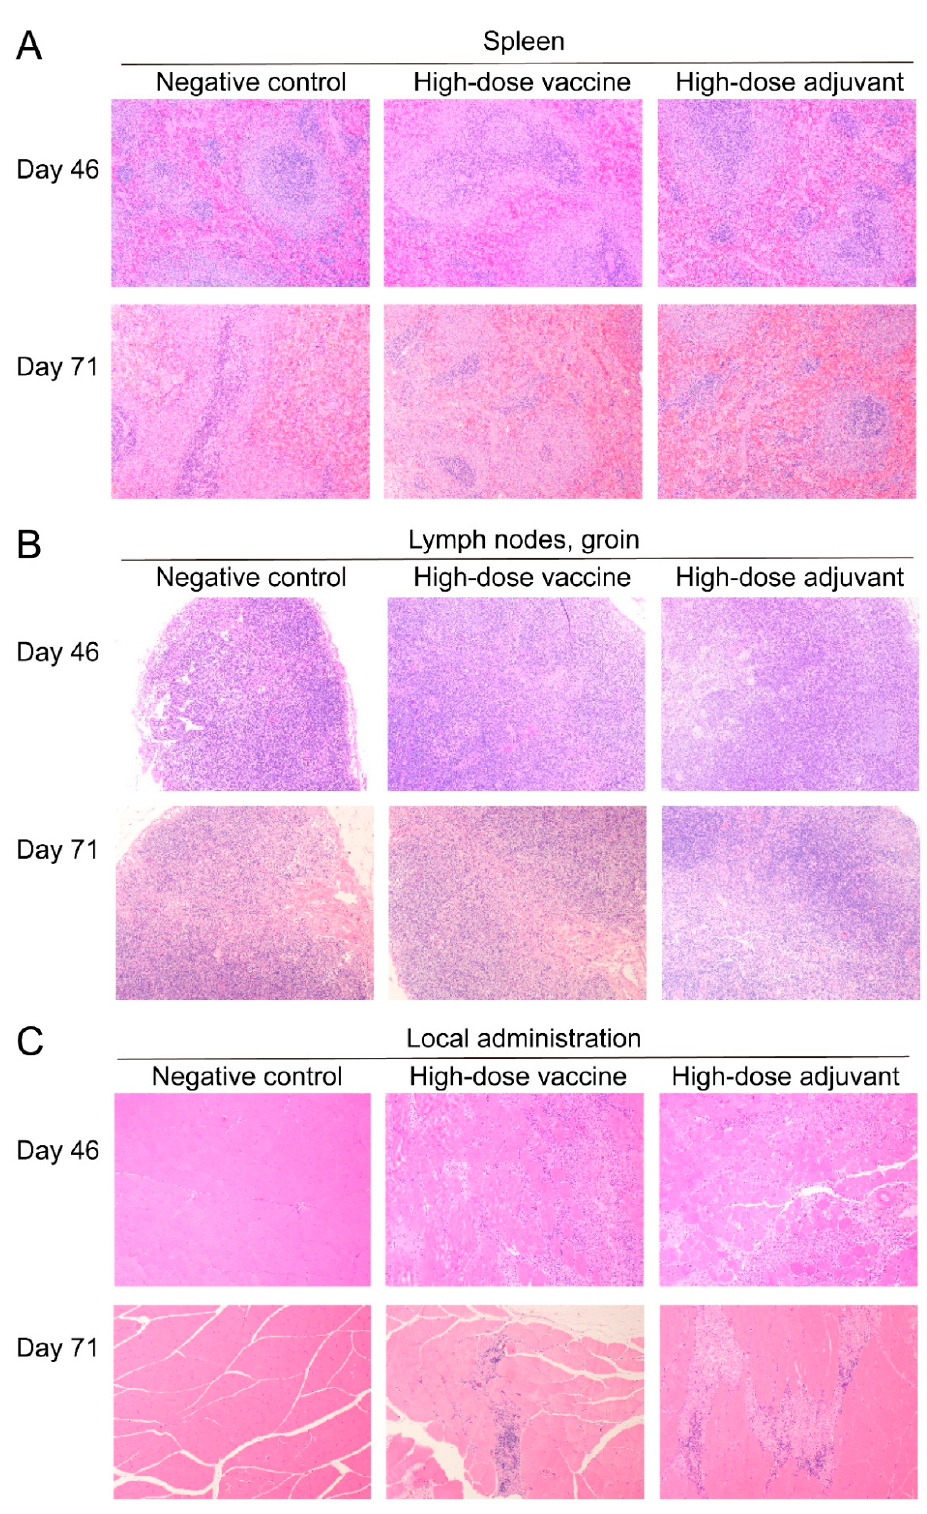
Figure 6. The results of the histopathological examinations for pathological changes in ( A ) spleen, ( B ) lymph nodes and groin and ( C ) local administration. H&E, 100×. ( B ) lymph nodes and groin and ( C ) local administration. H&E, 100 ×